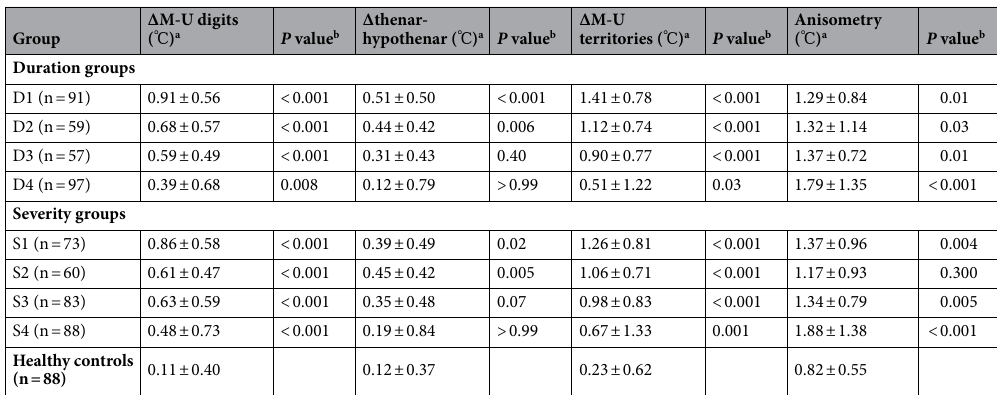
Table 3. Values of each index according to the symptom duration and disease severity groups. D symptom duration group, S severity group, ΔM-U digits temperature difference between the median and ulnar nerve digits, Δthenar-hypothenar temperature difference between the thenar and hypothenar areas, ΔM-U territories temperature difference between the median and ulnar nerve territories, Anisometry median nerve-innervated digits anisometry. a All continuous values were expressed as mean ± standard deviation. b Independent t -test between each patient group and the control